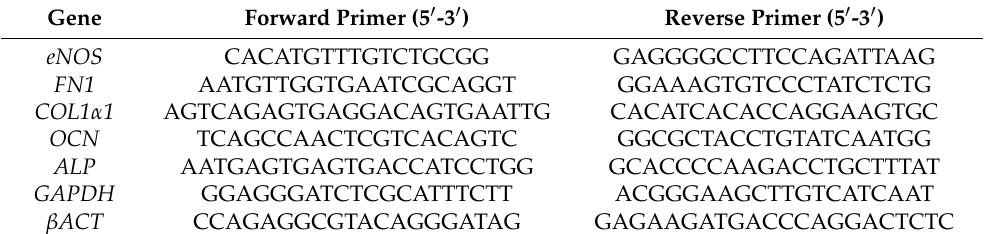
Table 2. Primer sequences used in